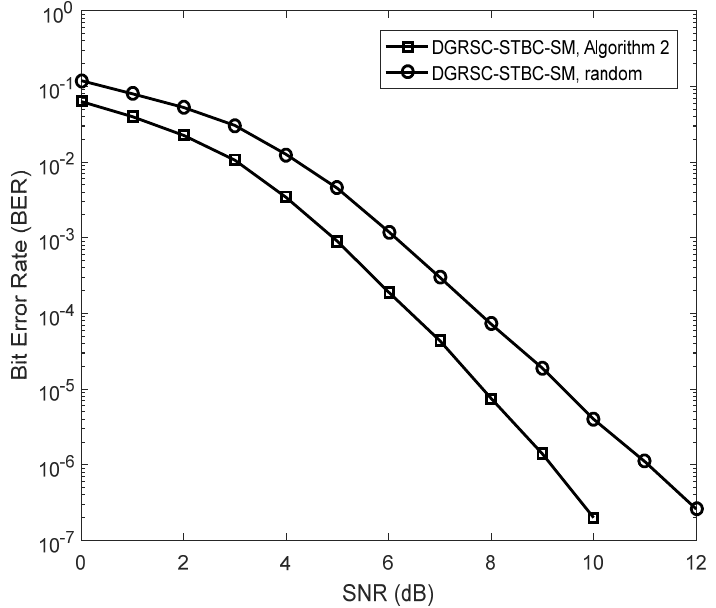
Figure 6. Error performance for DGRSC − STBC − SM using C S ( 63, 51, 13 ) and C R ( 63, 31, 33 ) under different selection algorithms, N t = N r = 4 and 4 −